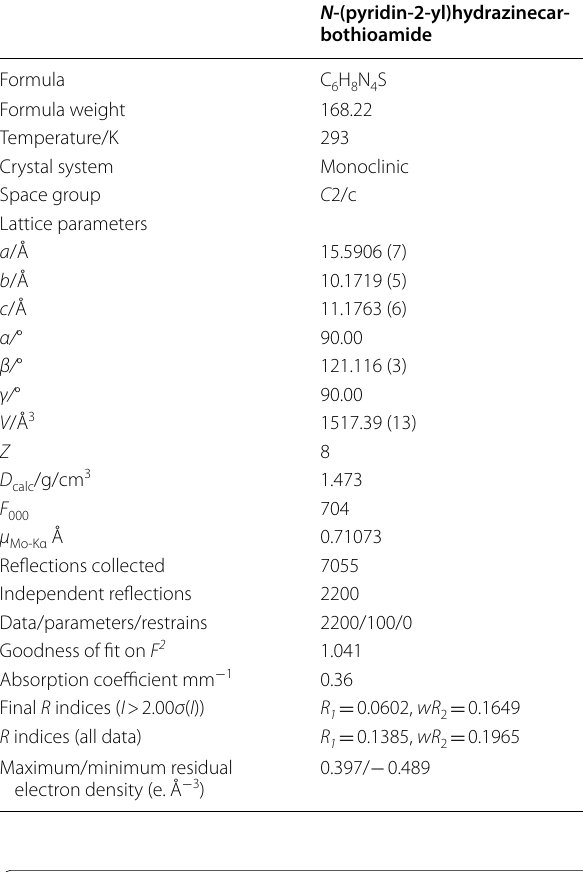
Table 3 Crystallographic data for N -(pyridin-2-yl)hydrazi- necarbothioamide